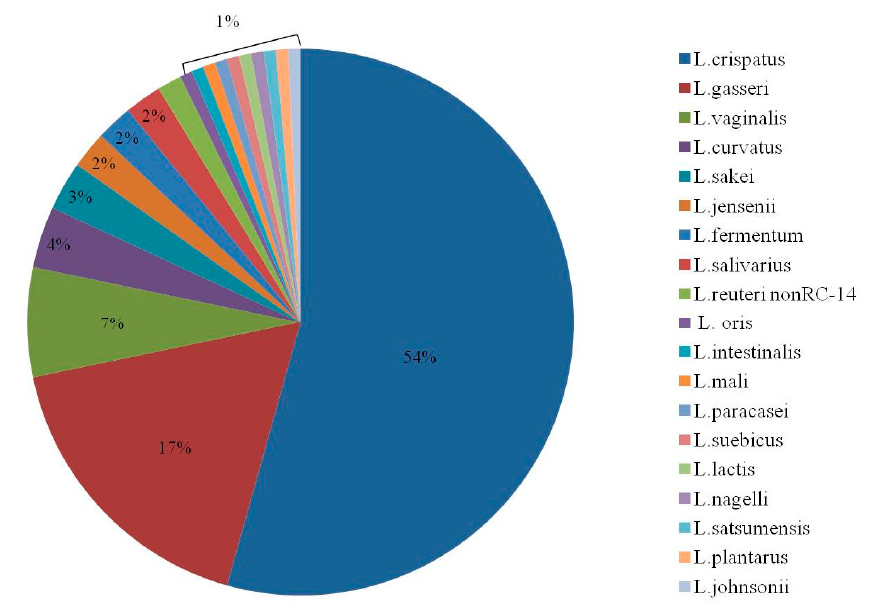
Figure 3. Percentage of native lactobacilli in vaginal specimens.